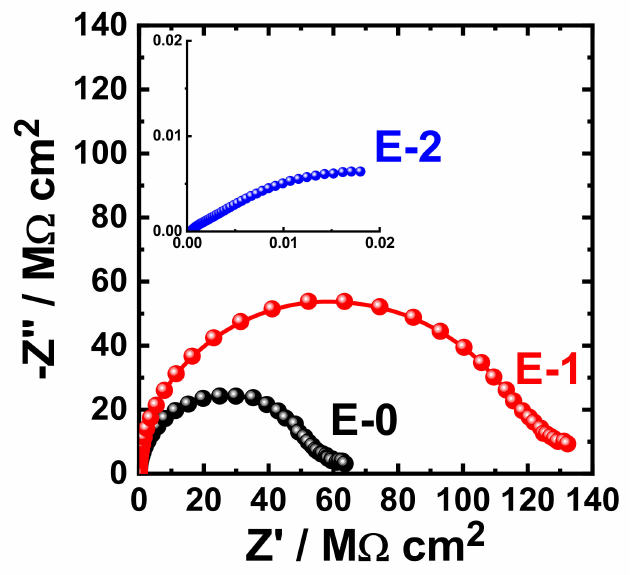
Figure 10. Typical Nyquist plots obtained for E-0, E-1, and E-2 after their immersion in 3.5% NaCl solutions for 7 days.